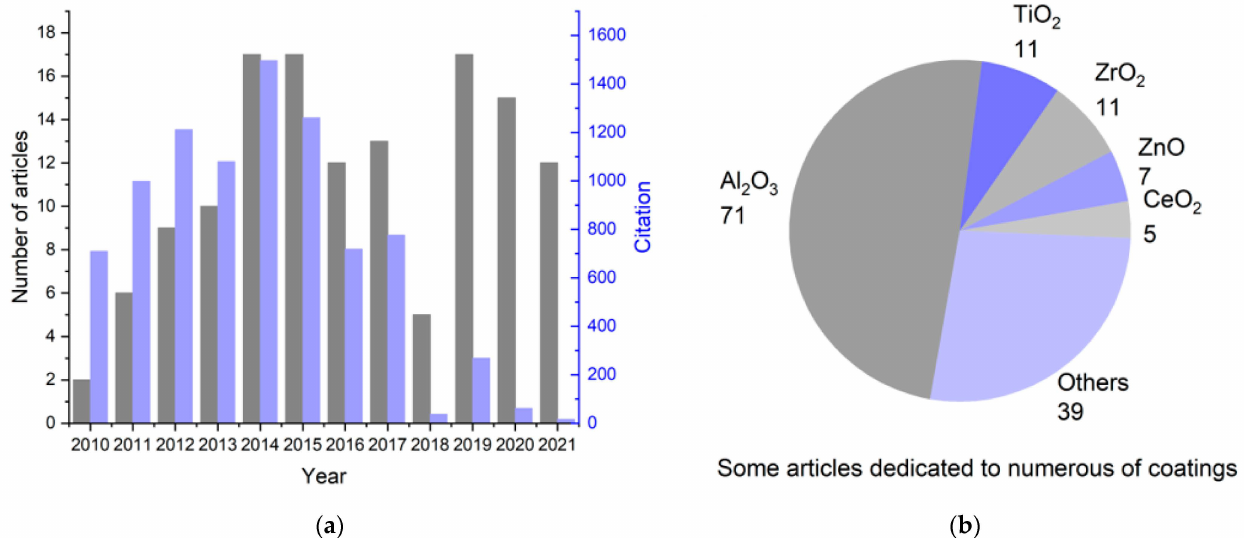
Figure 1. Summary statistics on the study of the literature about the synthesis of coatings on the cathode materials of lithium-ion batteries using ALD: ( a ) change in the number of publications related to ALD modification of cathode materials and their sum citation by year for 2010–2021; ( b ) number of articles devoted to a particular